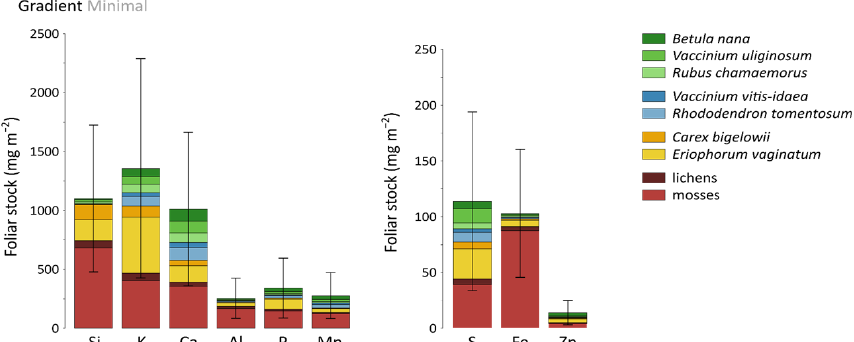
Figure 7. Cumulative mineral element stocks (mgm − 2 ) into foliar tissues of vascular species and tissues of non-vascular species across the least degraded area (Minimal) of the thermokarst gradient (Gradient) in 2017. Vegetation is sorted by plant functional types: deciduous shrubs and forbs (green), evergreen shrubs (blue), sedges (yellow), and lichens and mosses (red). Error bars represent standard deviations.